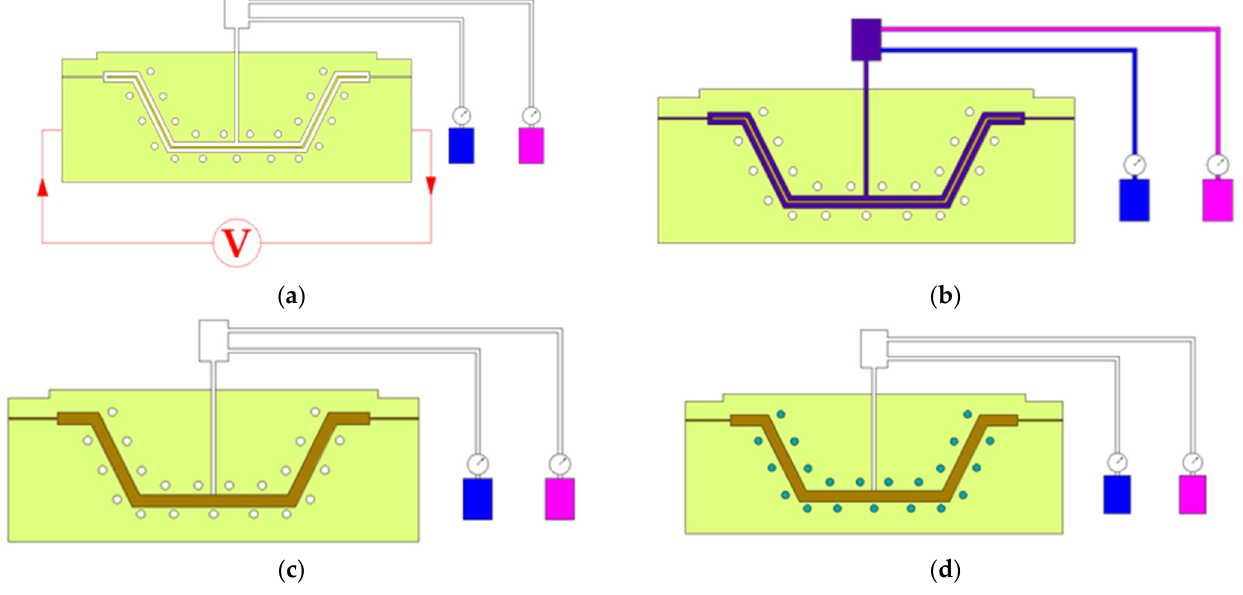
Figure 1. Different stages of a typical RTM process: ( a ) preheating of the mould, ( b ) resin filling, ( c ) curing stage, and ( d ) cooling down phase.